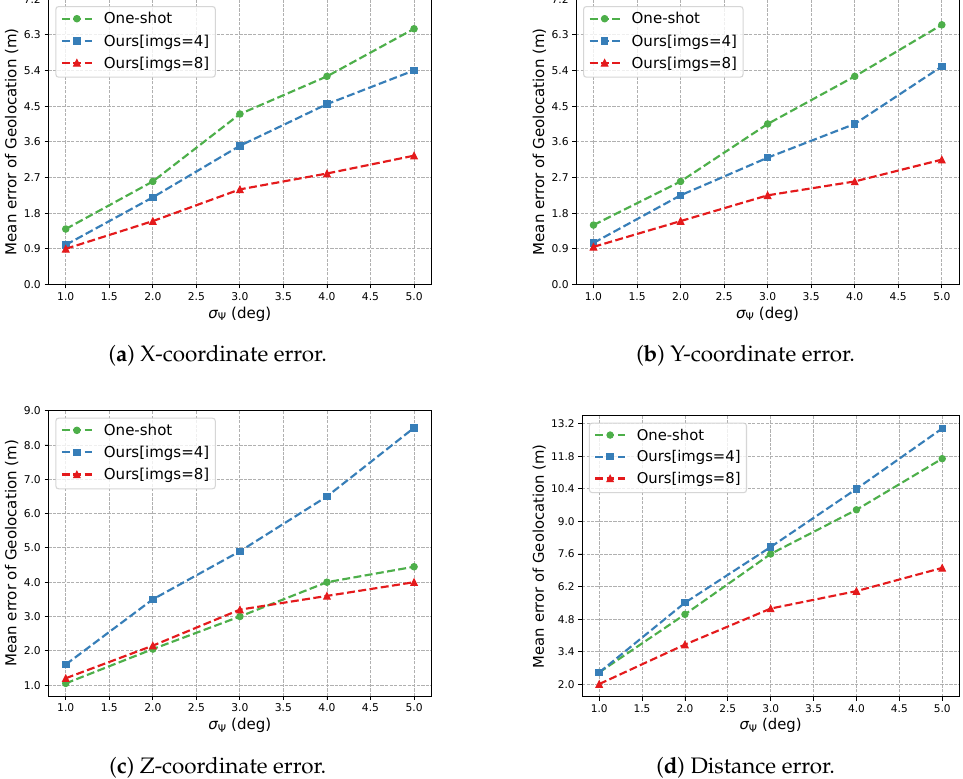
( d ) Distance error.